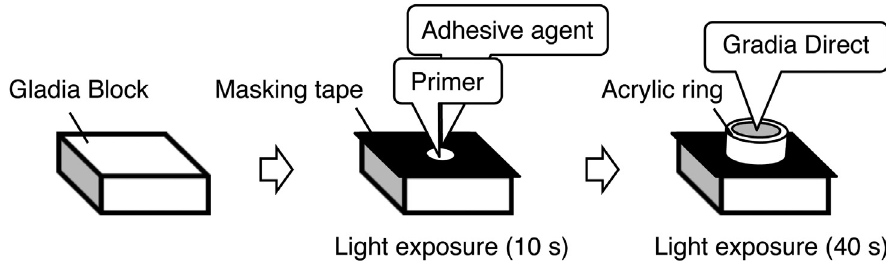
Figure 2- Schematic illustration of the bonding